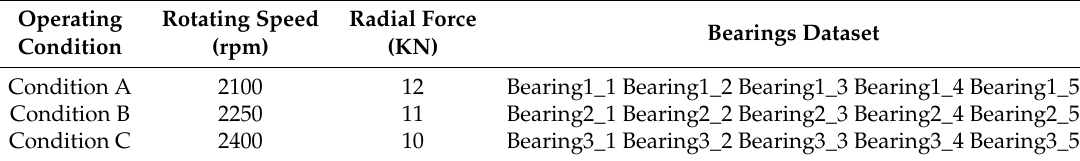
Table 1. Operating Conditions of the Tested Bearings.